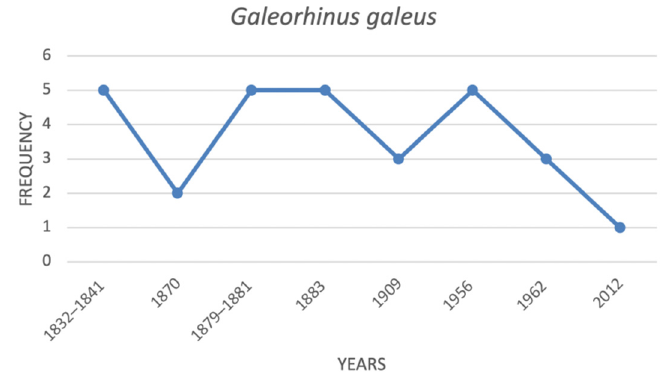
Figure 10. Temporal trend of Galeorhinus galeus .